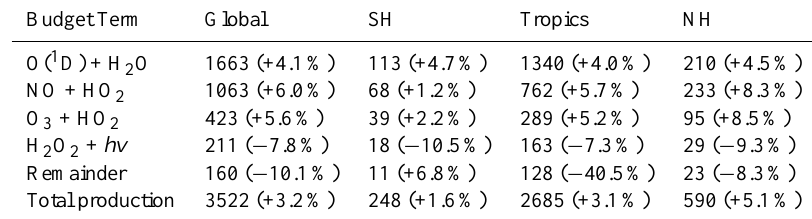
Table 5. As Table 2 but for the chemical production of OH and budget terms given in TgOHyr − 1 . Budget Term